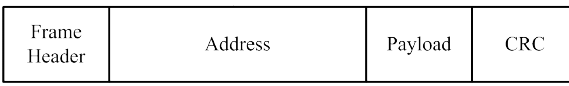
Figure 11. Wake up packet.